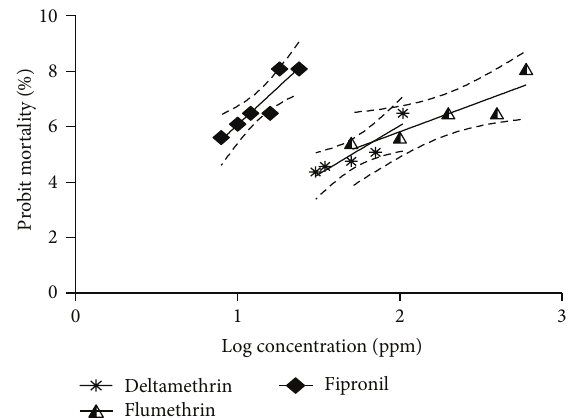
Figure 1: Comparative probit mortality in fully engorged adult R. (B.) microplus subjected to dose response AIT assay with deltamethrin, flumethrin, and fipronil.